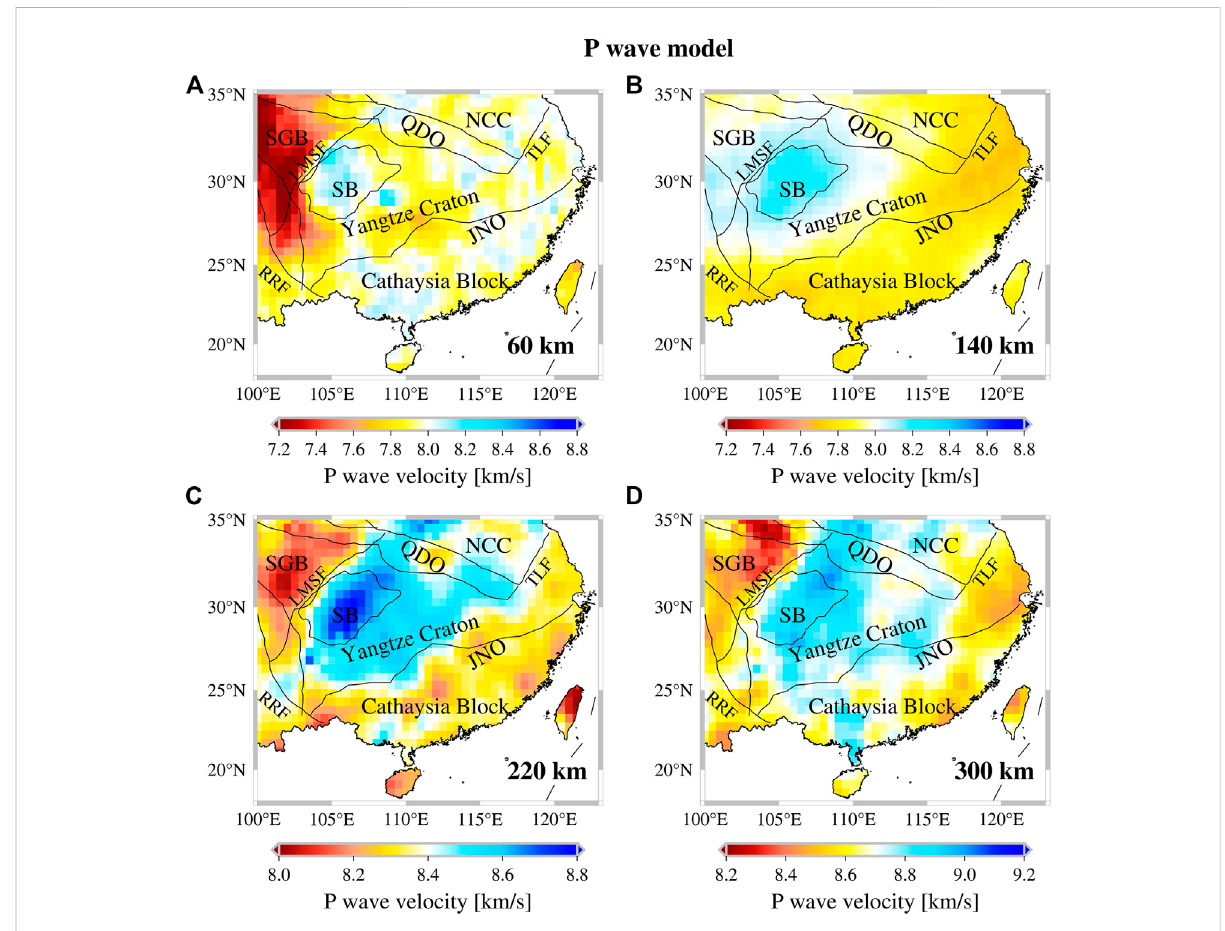
FIGURE 10 P wave velocity of the mantle component of SREM-SC at depths of (A) 60 km (B) 140 km (C) 220 km, and (D) 300